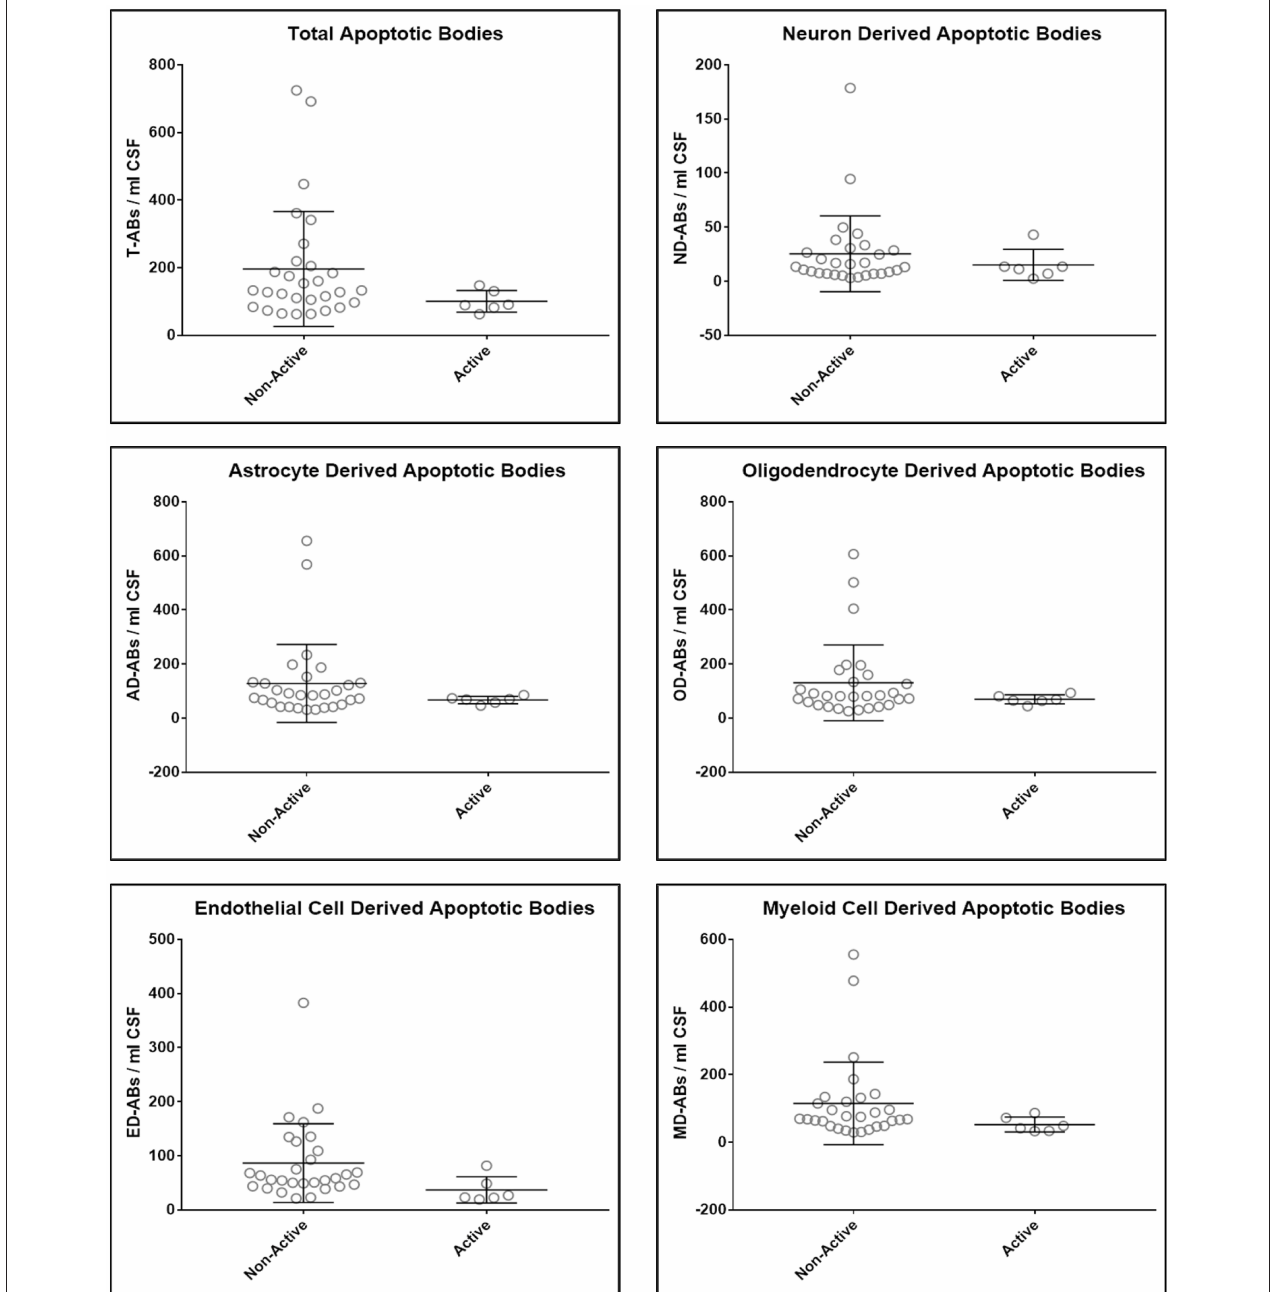
FIGURE 5 | Plots of total and CNS cell-specific ABs adjusted for CSF volume (ABs/ml CSF). Each point represents individual MS subject; and error bars represent standard deviation ( n : non-active MS = 29 and Active MS = 6); data were analyzed using nonparametric (Mann–Whitney) test.